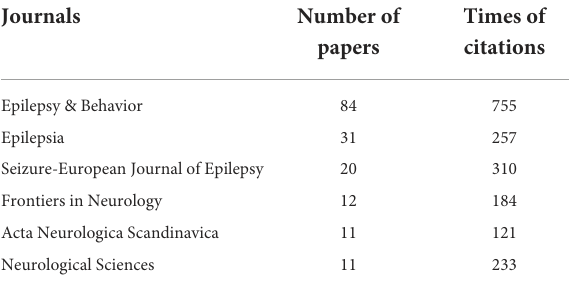
TABLE 1 List of journals with 10 or more papers related to COVID-19 and epilepsy.